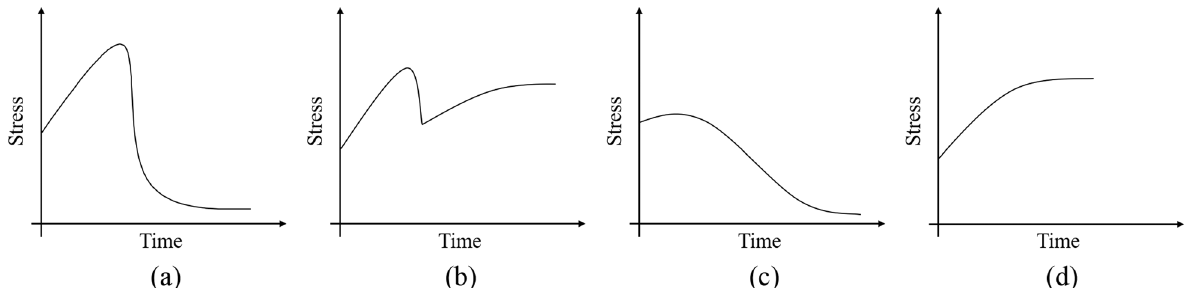
Fig. 36 Different types of stress curves with